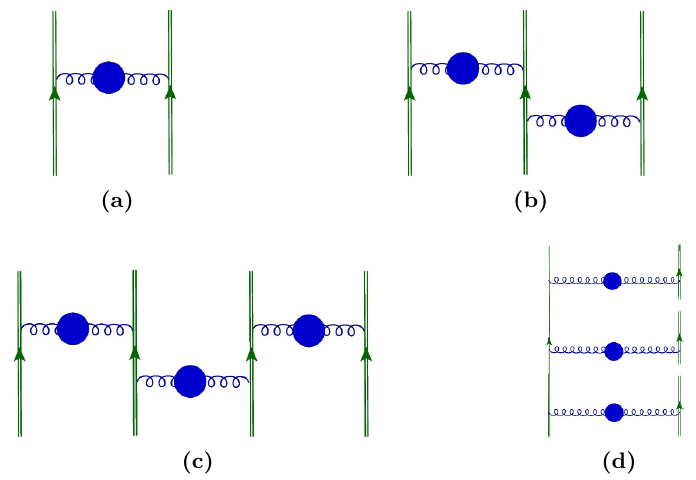
Figure 5. Basis Cwebs upto three